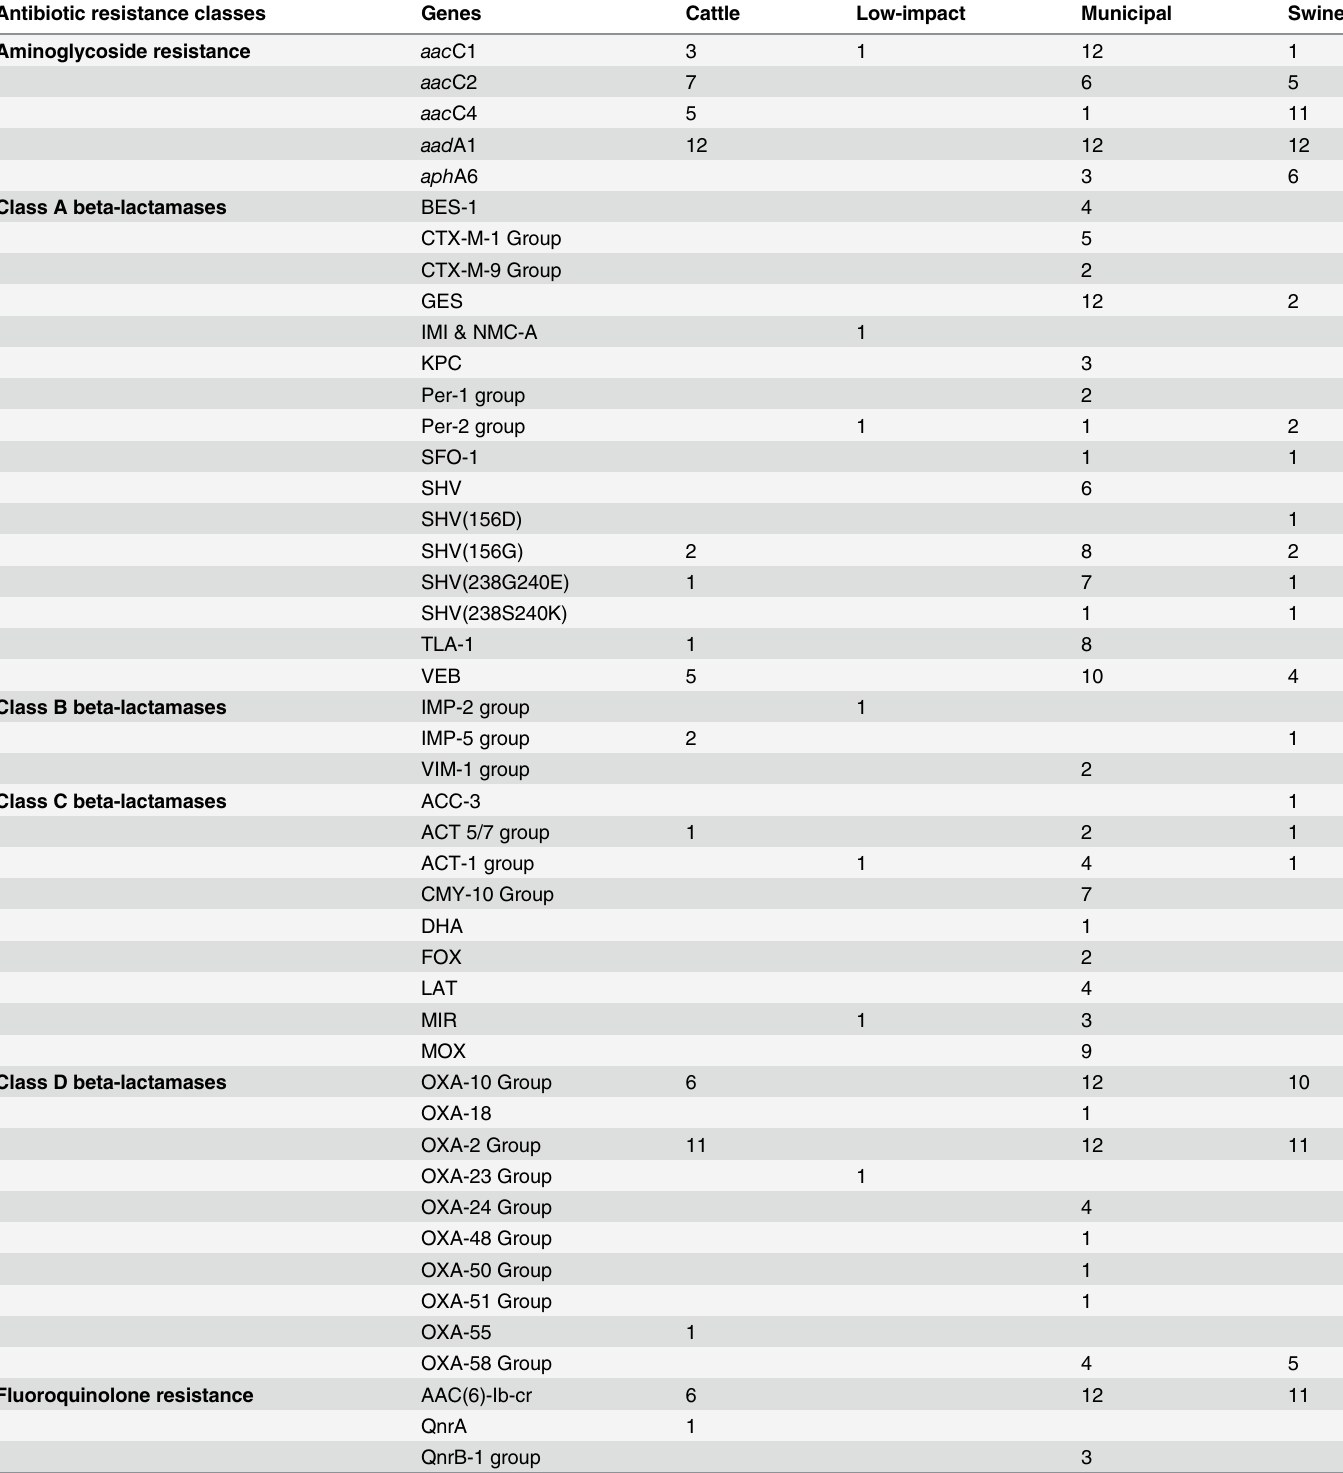
Table 3. Number of cattle (n = 12), low impact environment (n = 8), municipal (n = 12) and swine (n = 12) pooled samples harboring specific antimi- crobial resistance